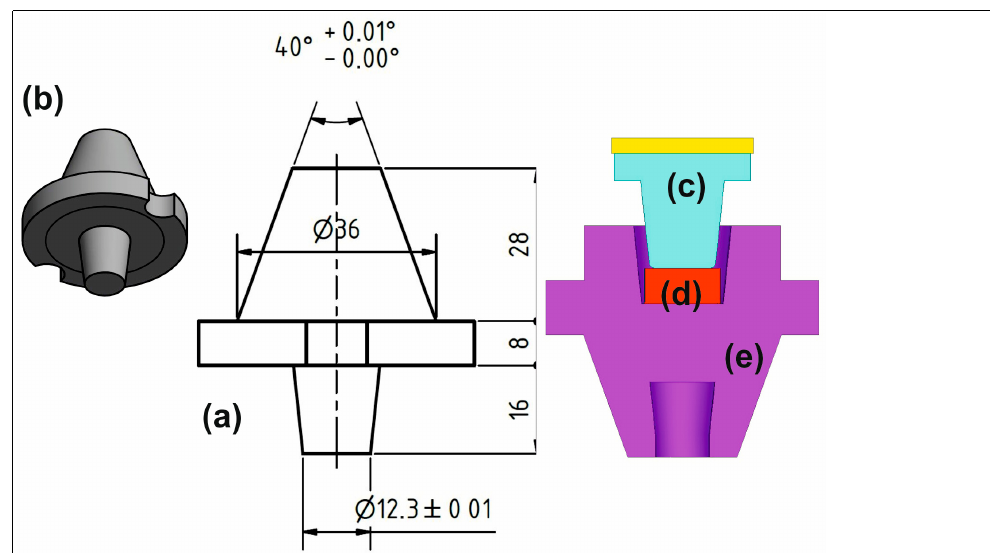
Figure 2. Simulation bodies: ( a ) upper punch geometry, ( b ) 3D upper punch, ( c ) active part of upper punch, ( d ) sample, ( e ) lower punch.